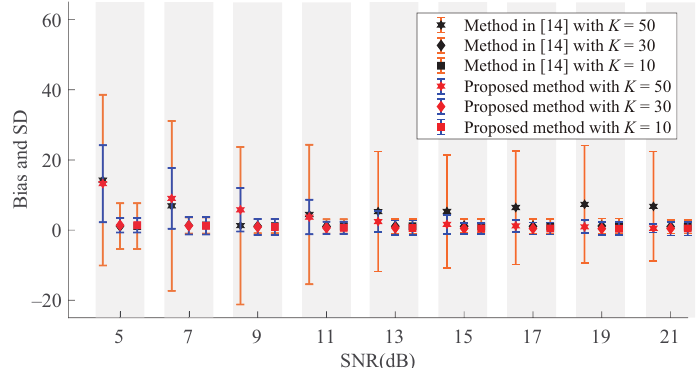
Figure 3. Bias and SD of bandwidth detection at different noise levels.